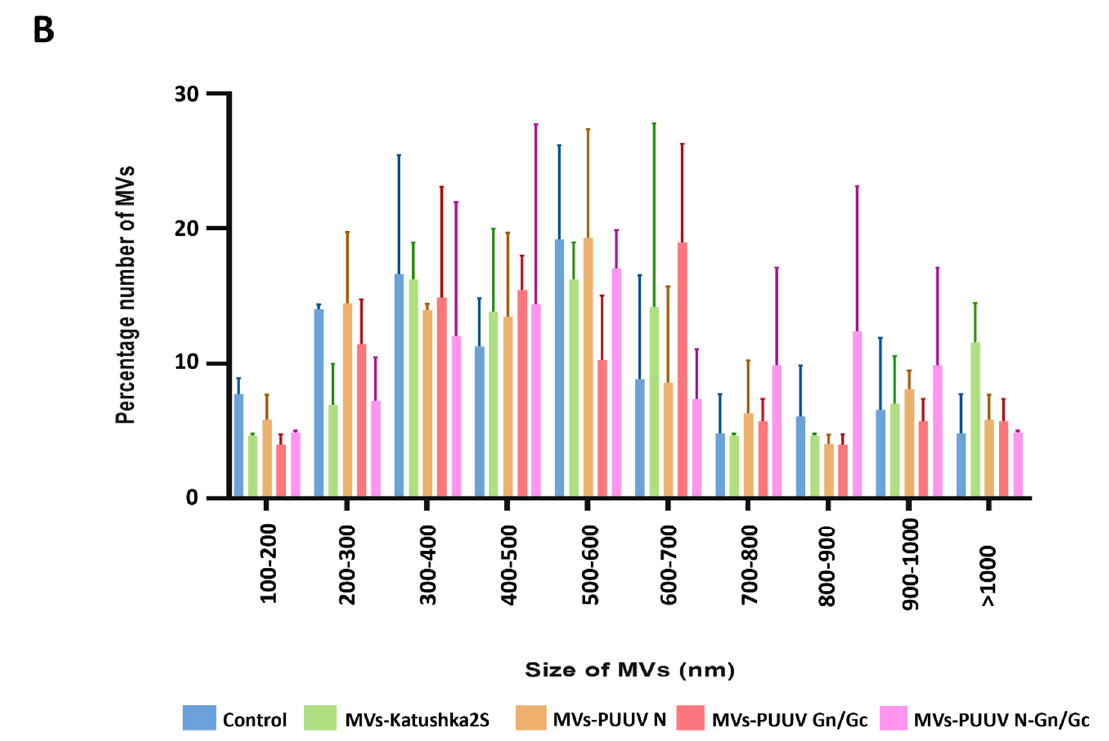
Figure 2. The structure and size distribution of MVs. ( A )—TEM analysis was used to analyze the structure of mMSC-derived MVs (scale bar 1 µ m). The diameter of the MVs (black lines) in each experimental group was calculated individually (five images per group) using ZEN 2 Blue Edition software. One example figure was demonstrated for each group: I—control MVs; II—MVs-Katushka2S; III—MVs-PUUV N; IV—MVs PUUV Gn/Gc; and V—MVs-PUUV N and Gn/Gc. ( B )—The size distribution of MVs: control (blue); Katushka2S (green); PUUV N (orange); Gn/Gc (red); and a combination of N and Gn/Gc proteins (pink). MVs from non-transduced cells were used as the control. Data are presented as the percentage of MVs in each size range SD. ±